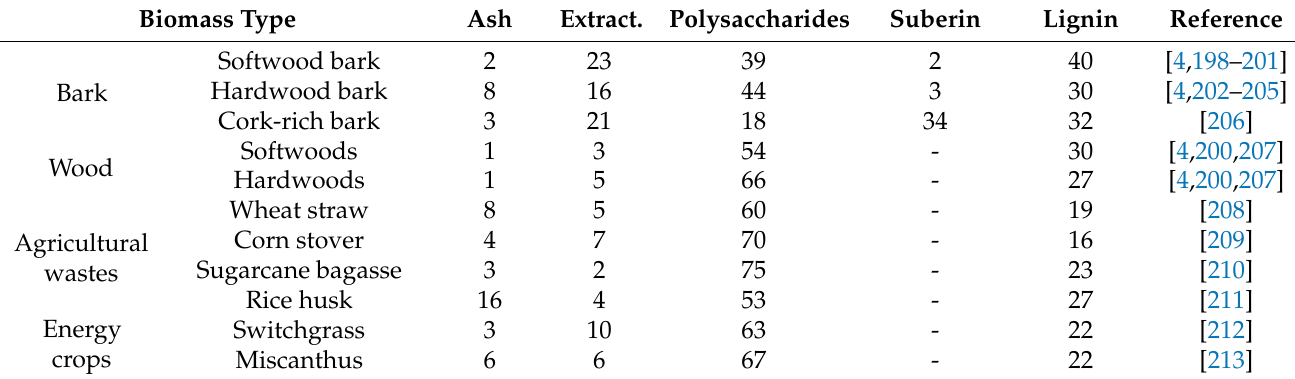
Table 2. Differences in average chemical composition (% dry mass) between bark and other lignocellulosic materials. Biomass